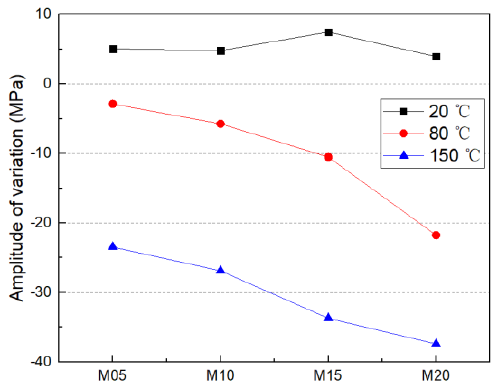
Figure 7. Amplitude of variation of peak stress compared with M0.